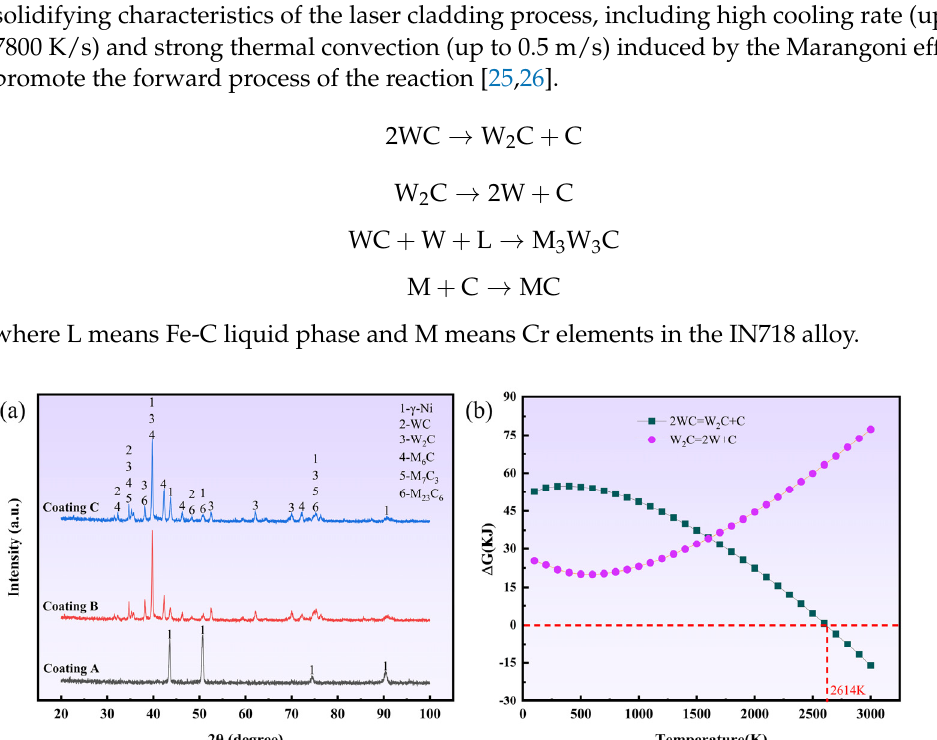
Table 3. Physical properties of bonding metal IN718 alloy and WC particles.